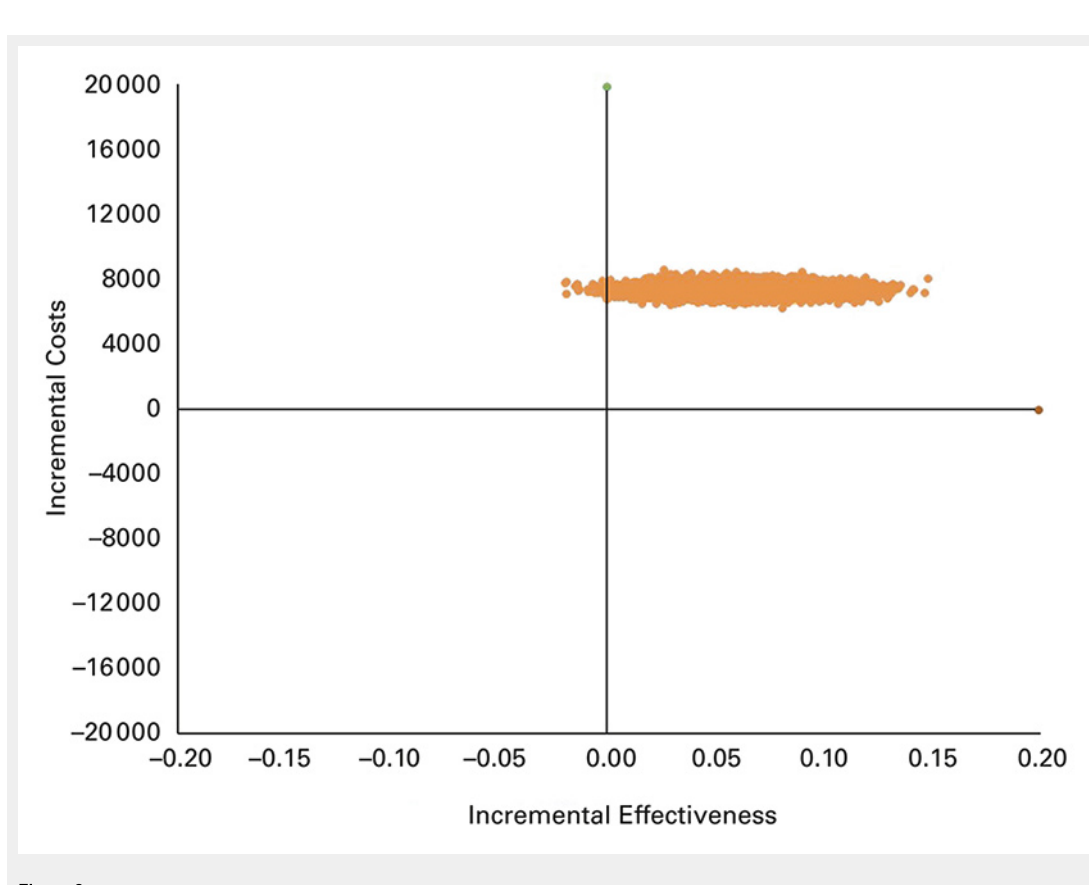
Figure 2 Scatter plot of incremental costs per person and incremental effectiveness derived from 10 000 iterations of the Monte Carlo simulation. Incremental effectiveness is expressed as quality adjusted life years (QALYs) gained and incremental costs are in CHF, from the healthcare system